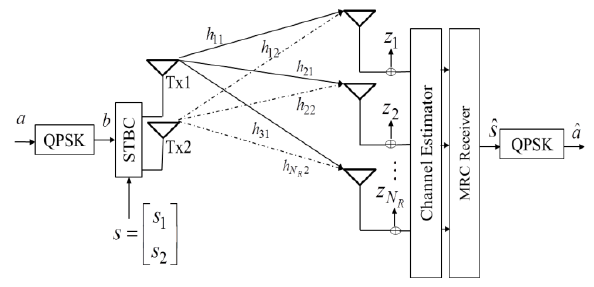
Figure 5: Architecture for Implementing STBC